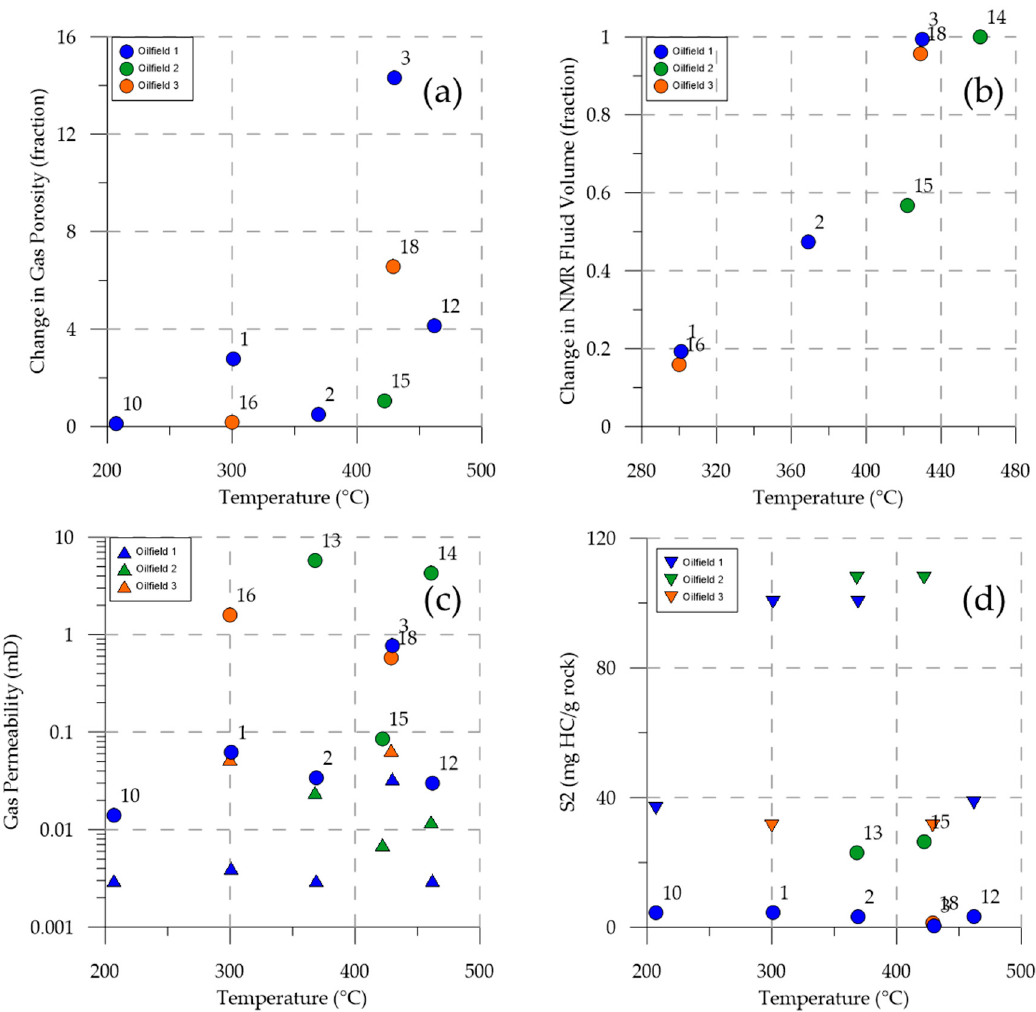
Figure 14. Cross plot of ( a ) porosity by gas; ( b ) permeability; ( c ) residual saturation by NMR; ( d ) residual TOC vs. temperature. Change of porosity and NMR fluid volume is calculated as follows: Change (fraction) = (parameter before CT − parameter after CT/parameter before CT). Triangle-shaped symbols indicate the measured parameter before CT. Samples #13 and #14 are not demonstrated at ( a ) due to high values of gas porosity (see Table 4).